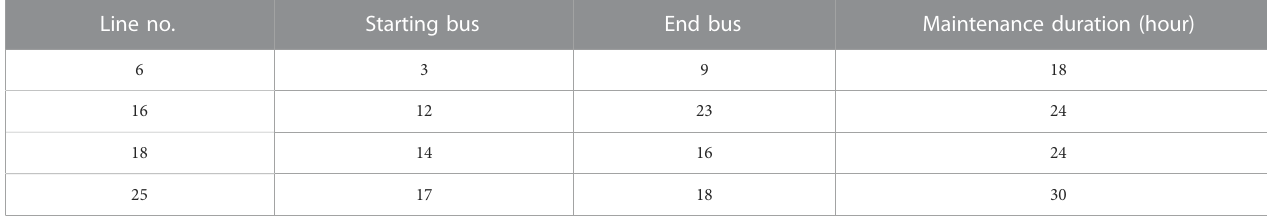
TABLE 1 Maintenance data of defective transmission lines. Line no.